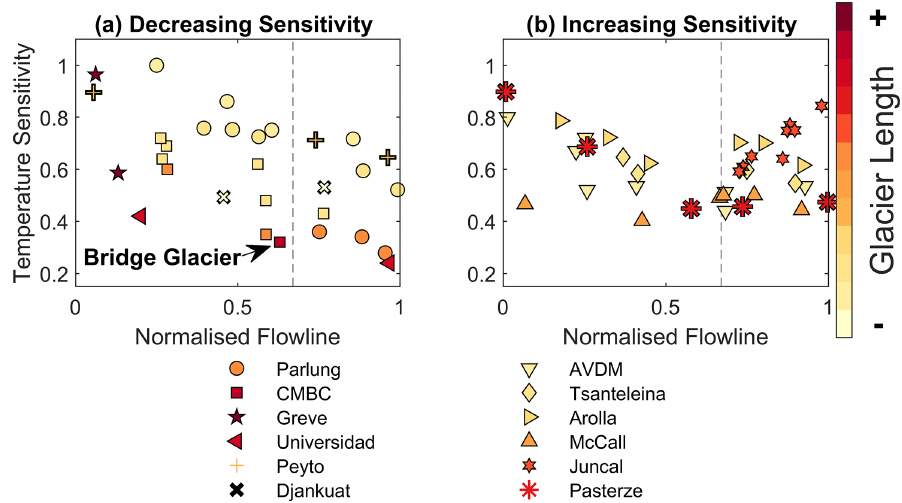
Figure 10. The k 2 sensitivity along the normalised flowline compared to total glacier length (colour bar). Glaciers have been grouped in two clusters: (a) those with down-glacier decreasing sensitivity, and (b) those with increasing sensitivity towards the glacier